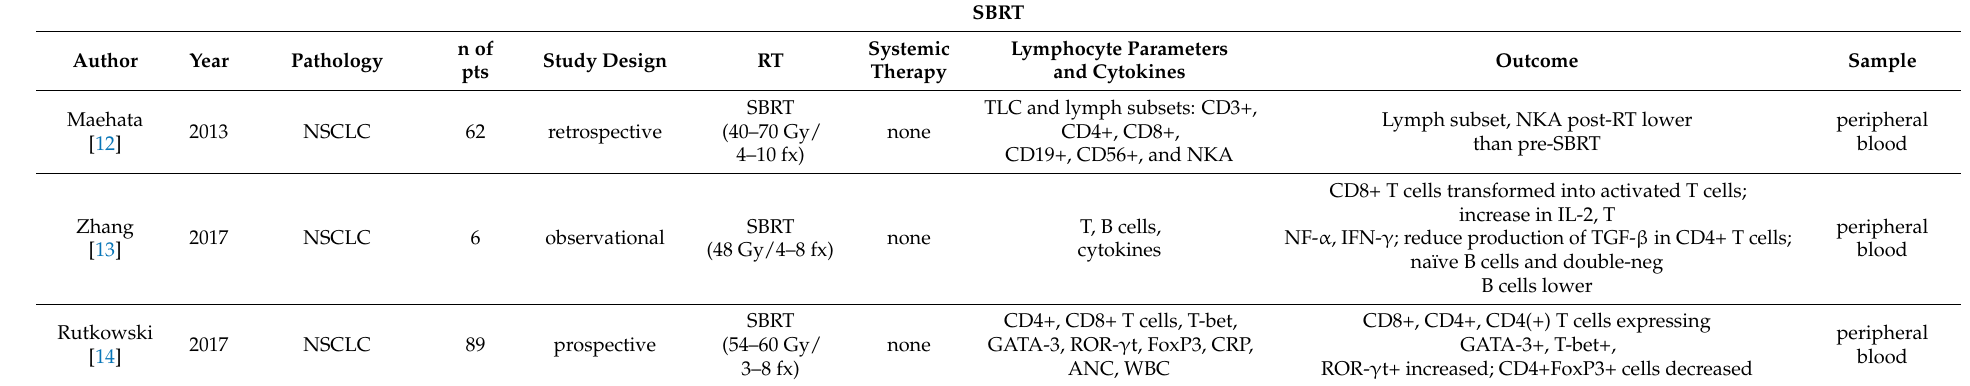
Table 2. Stereotactic body radiation therapy